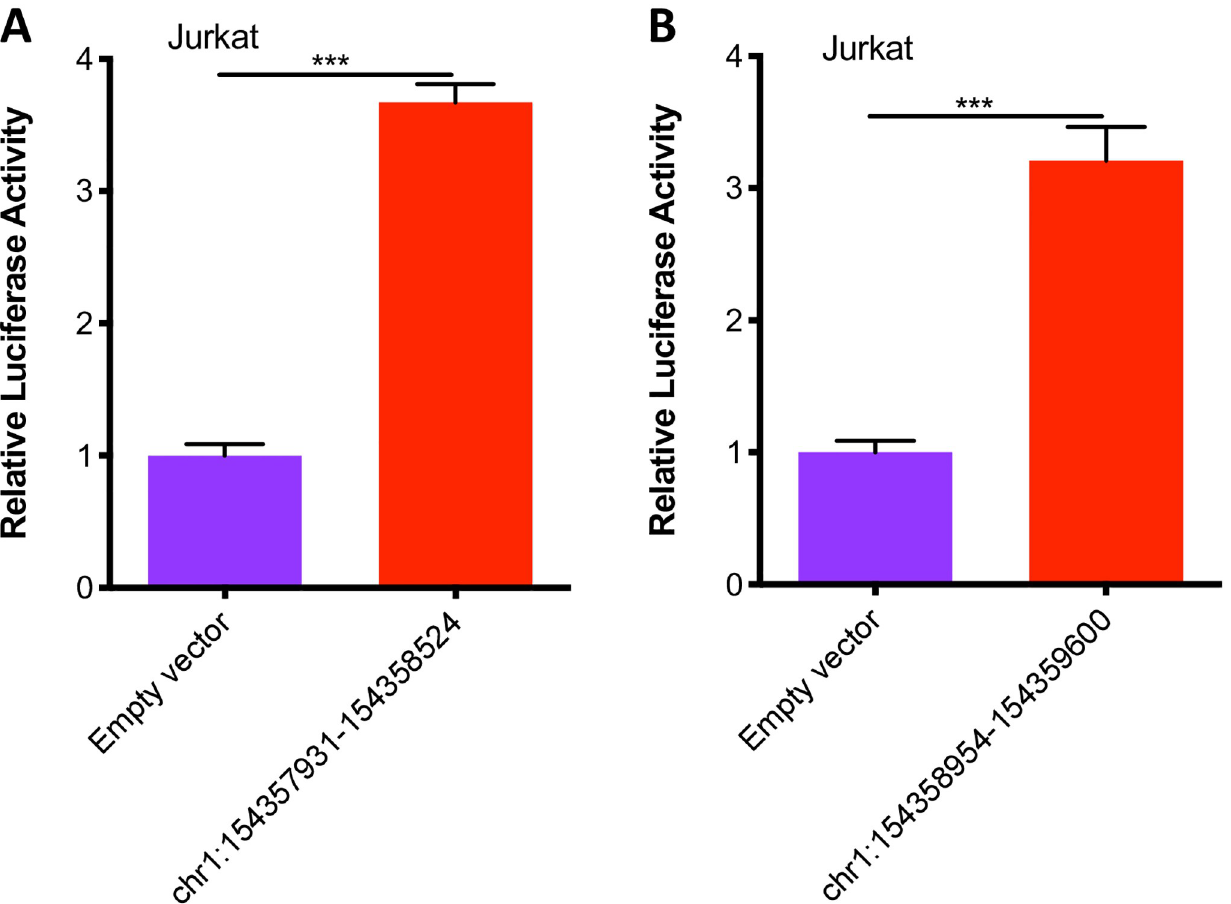
Fig 5. Summary of results from luciferase assays assessing enhancer activity at the IL6R locus in Jurkat T cells. A and B. The results are from 594bp and 647bp constructs, respectively, with the constructs tiled across an H3K4me1/H3K27ac-marked region within JIA-associated haplotype in IL6R region. Chromosome coordinates for each construct are indicated beneath each bar. Both constructs showed enhancer activity in Jurkat T cells. The empty vector (negative control) is the basic pGL4.23 vector (which contains the SV40 promoter but is inefficient at driving luciferase expression). Data are represented as mean ± SEM of 6 biological replicates, and p values are calculated using Student’s t test. ��� p �